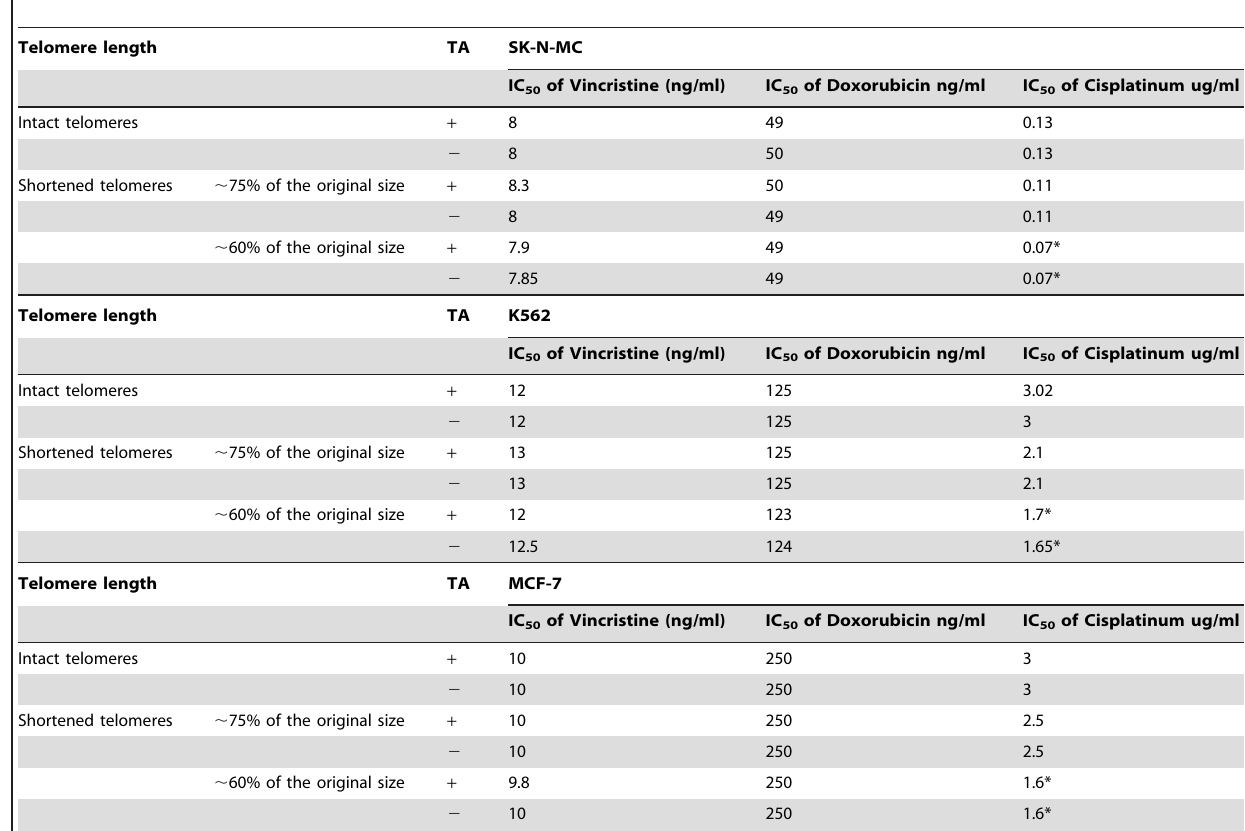
Table 1. Effects of telomerase inhibition and telomere shortening on the sensitivity of cancer cells to cytotoxic drugs.